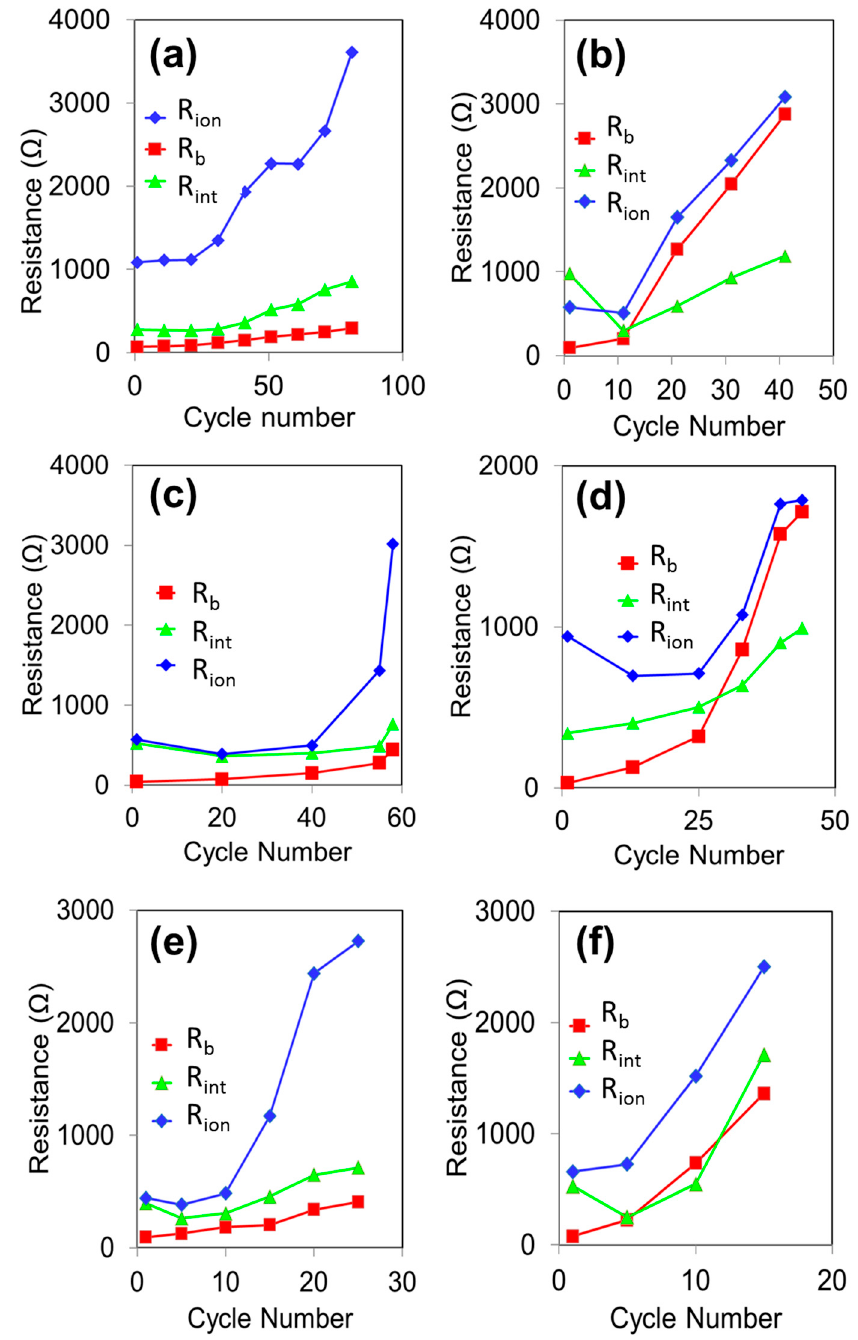
Figure 4. Change of resistances after the discharging ( a , c , e ) Palladium-filled CNT, and ( b , d , f ) palladium-coated CNT cycles of 250 mAh.g − 1 , 500 mAh.g − 1 , and 1000 mAh.g − 1 capacities, respectively.